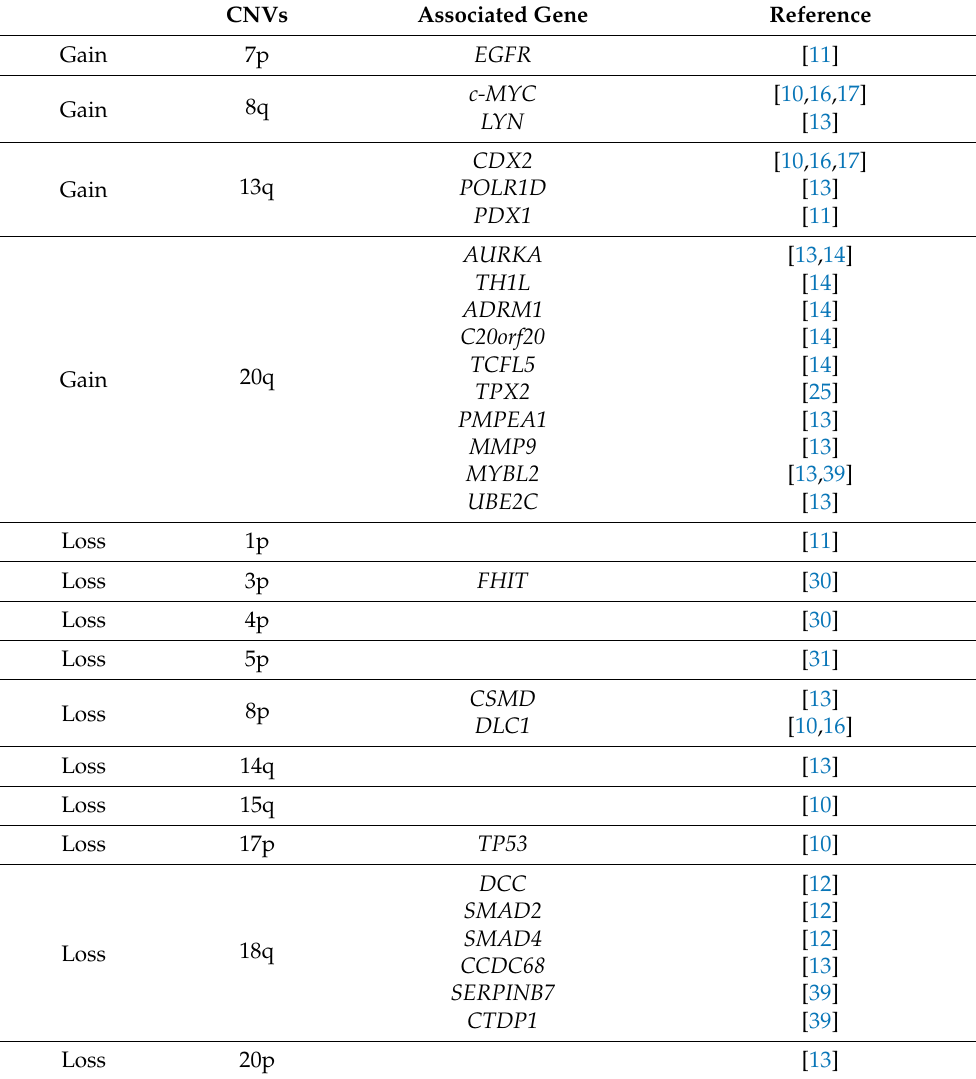
Table 1. The most common chromosomal alterations and associated genes involved in adenoma to carcinoma progression.